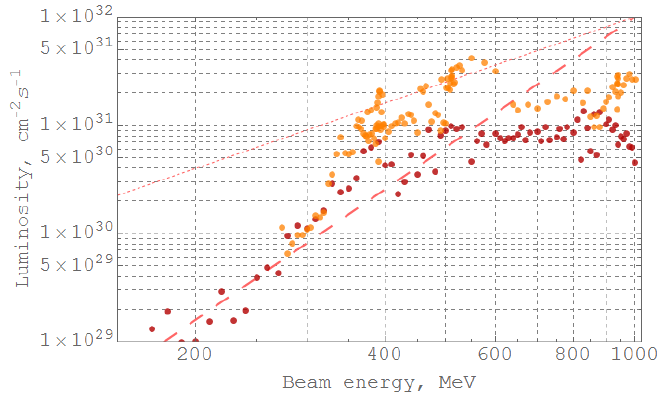
Fig. 7 CMD-3 recorded in 2010–2013 (crimson) and in 2017–2018 (orange) luminosity averaged over 10% of best runs. Pink lines show scaling laws with fixed and variable β *.